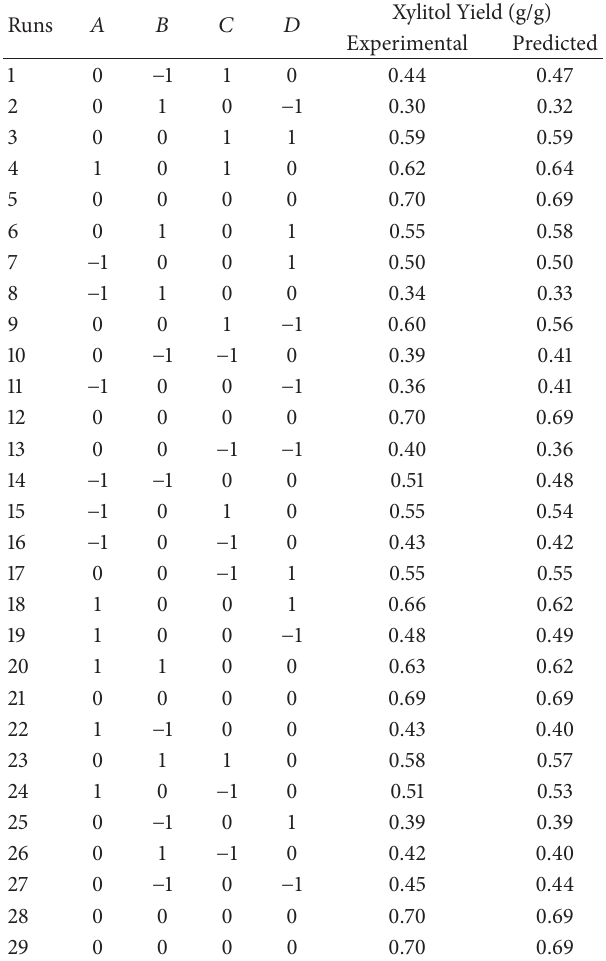
Table 2: Ranges of variables used in Box-Behnken design. S. no